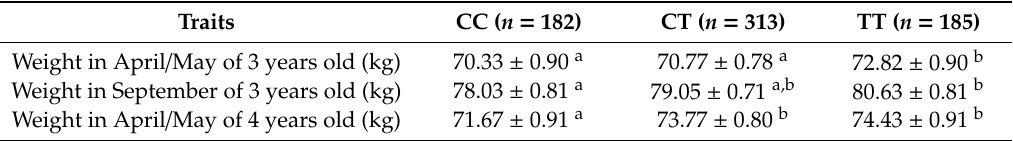
Table 1. Association of TMEM8B rs426272889 with ewe mature weights showing adjusted means and standard errors from Rambouillet, Polypay, and Targhee sheep.